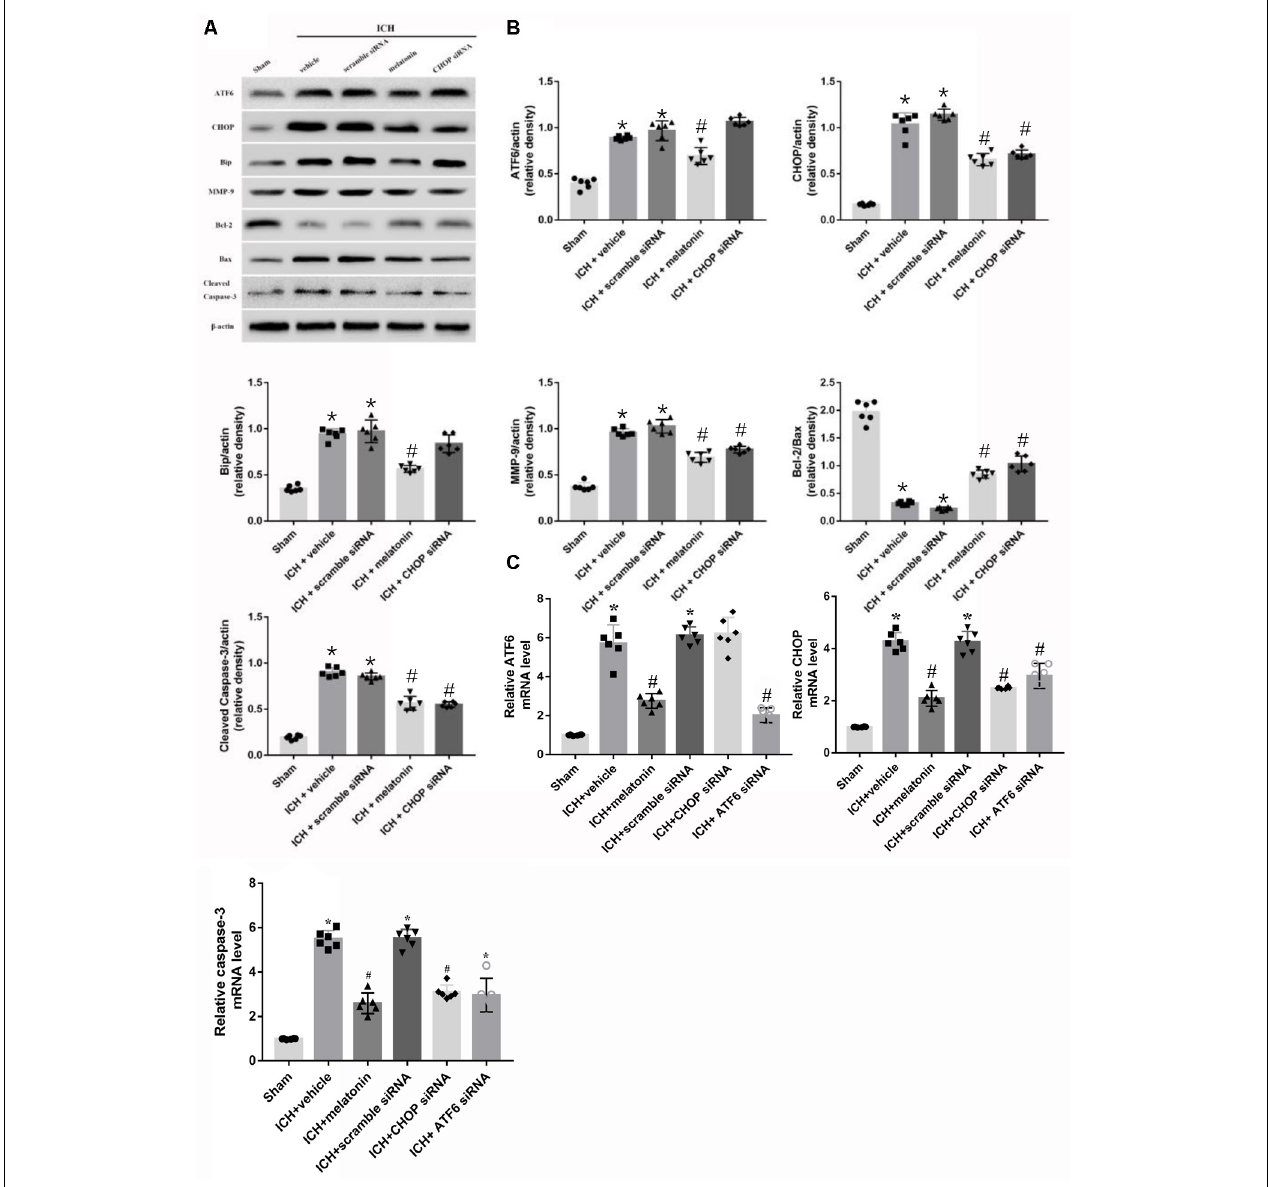
FIGURE 4 | Intraperitoneal administration of melatonin Promotes Neuronal Survival at 24 h after ICH. (A) Representative Western blot images. (B) Quantitative analyses of ATF6, CHOP, Bip, MMP-9, Bcl-2, Bax, cleaved caspase-3; (C) Relative level of mRNAs of ATF6, CHOP and caspase-3. n = 6 for each group. The bars represent the mean ± SD. ∗ p < 0.05 vs. sham, # p < 0.05 vs. ICH +